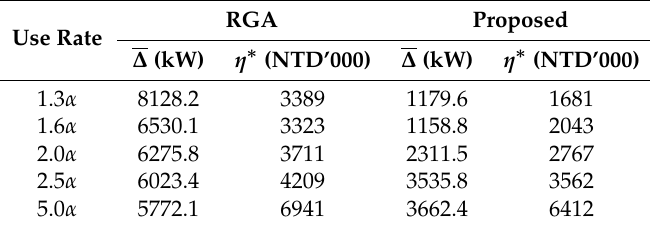
Table 6. Performance comparisons of all compared methods under different use rates for case 2 of demand